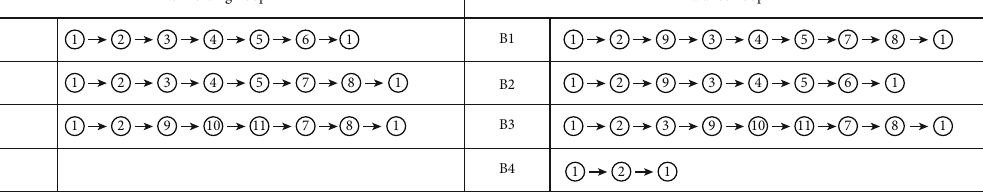
Figure 1: Causal loop diagram of the CLSC in this